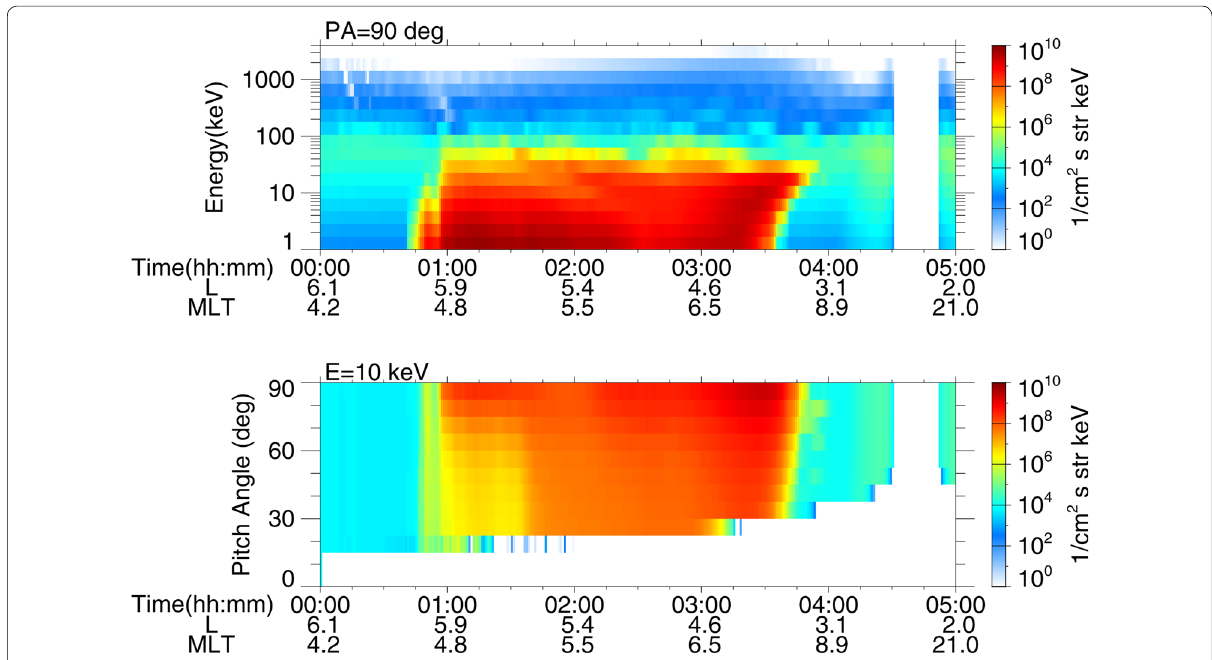
Fig. 6 Same as Fig. 5 except that Arase travels the same orbit 3 h